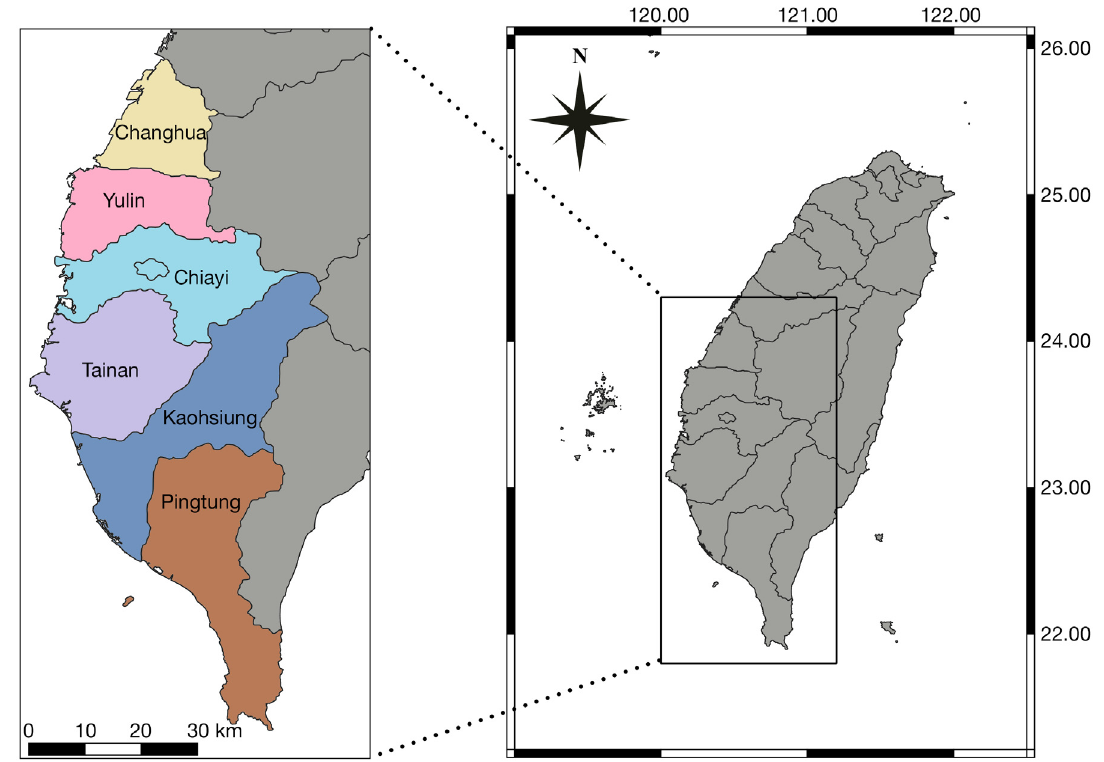
Fig. 1. Feasibility survey areas on coastal aquaculture in this research, located in southwestern